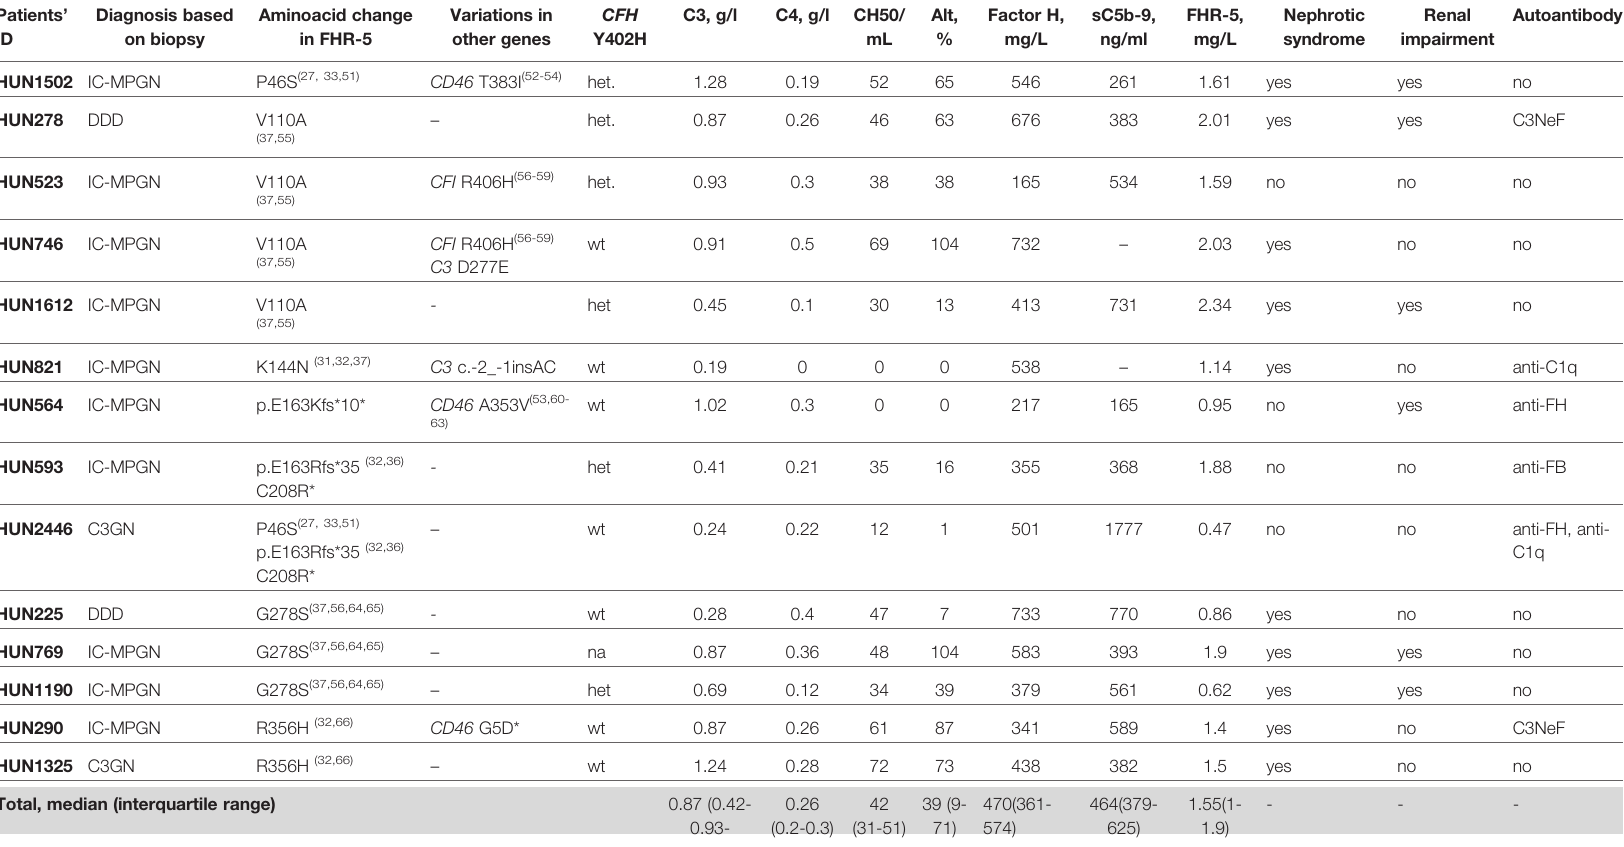
TABLE 3 | Identi fi ed variations in the CFHR5 gene in patients (n=14) with C3G/IC-MPGN. Patients